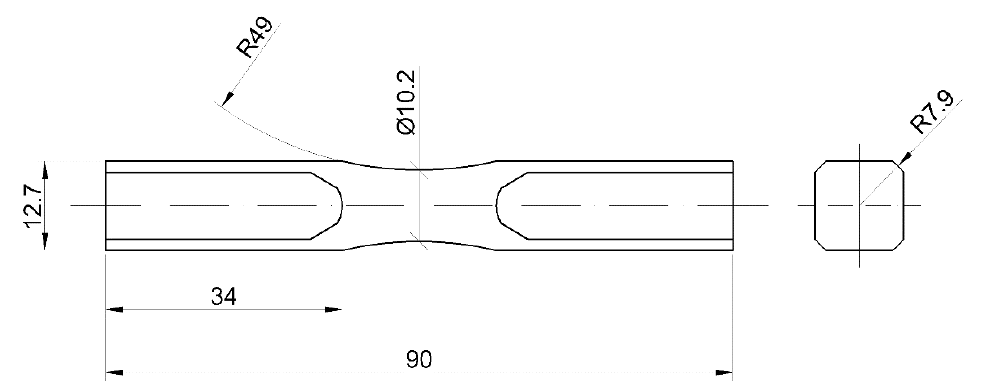
Figure 2. Geometry of samples used for fatigue testing (mm).